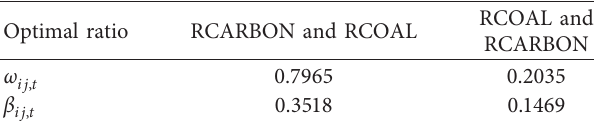
Table 10: Hedging